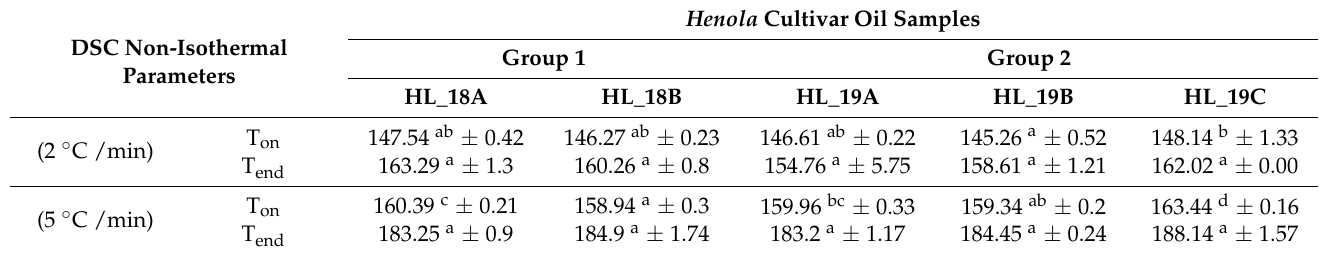
Table 6. Non-isothermal assessment of heating rate 2 and 5 ◦ C/min temperature programs using differential scanning calorimetry for cold-pressed hemp seed